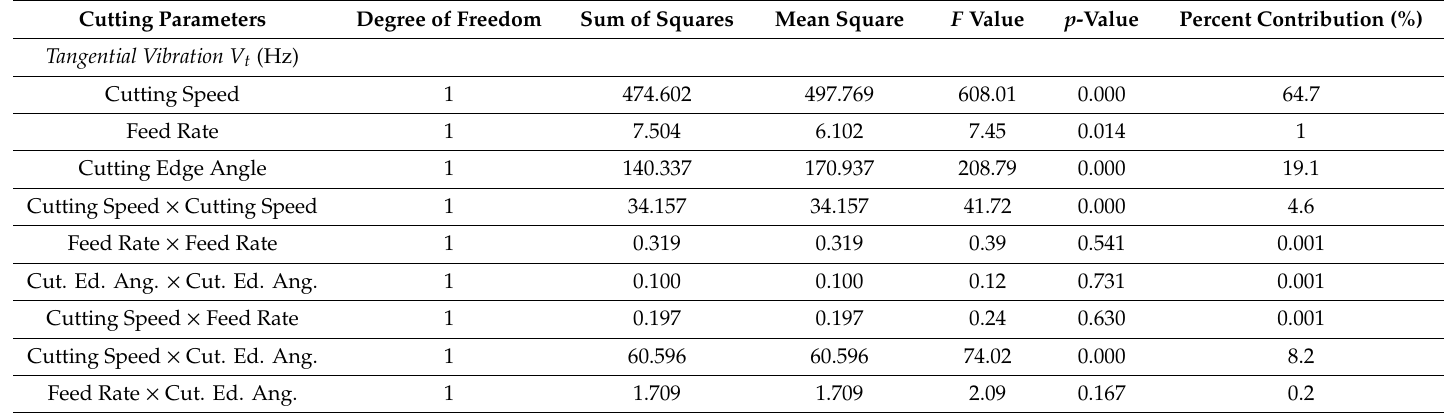
Table 6. ANOVA results for 3 components of